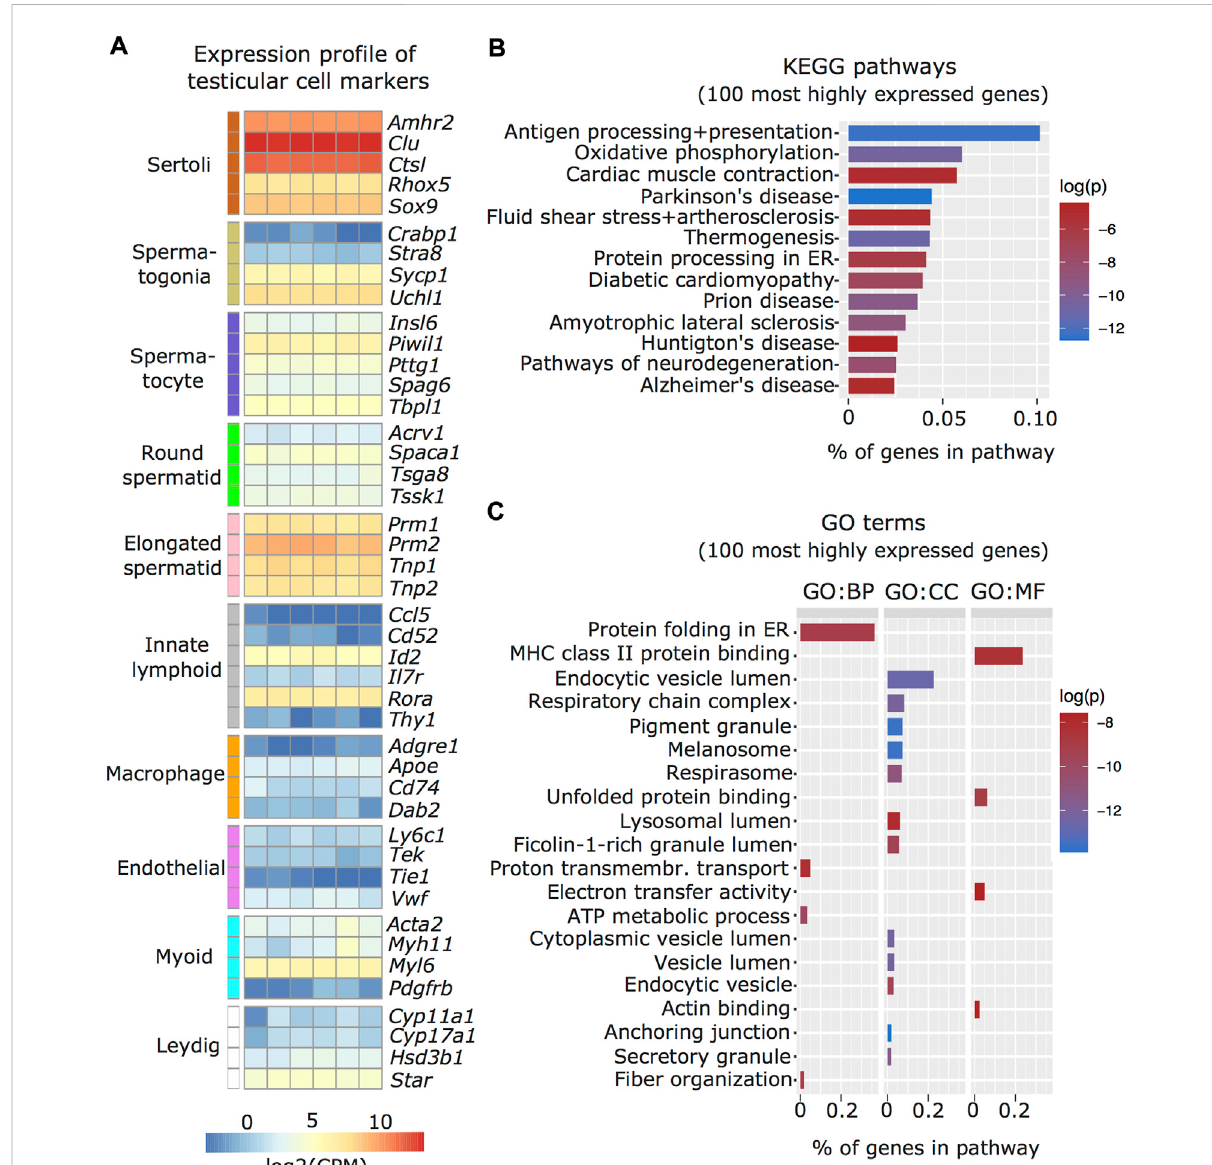
FIGURE 2 Characterization of enriched Sertoli cells by RNA sequencing. (A) Heatmap of testicular cell markers in enriched Sertoli cells, ordered by cell type-speci fi cityincludingSertolicells,spermatogeniccells(spermatogonia,spermatocyte,roundandelongatedspermatid),immunecells(lymphoid and macrophage), endothelial cells, smooth muscle cells (peritubular myoid) and endocrine cells (Leydig). Color scale indicates normalized log2 gene counts per million (CPM). Enriched (B) KEGG and (C) GO pathways for 100 most highly expressed genes in collected Sertoli cells including immunological (e.g. KEGG: Antigen processing and presentation; GO MF: MHC class II protein binding), metabolic (e.g. KEGG: Oxidative phosphorylation, GO CC: respiratory chain complex), cell-cell junction (KEGG: Cardiac muscle contraction, GO, CC: anchoring junction), phagocytosis (GO, CC: endocytic vesicle lumen, lysosomal lumen), and secretion (KEGG: protein processing in ER, GO, CC: secretory granule) pathways.Ratioofgenesperpathwayisgivenonthex-axisandlogofp-value(log( p ))isindicatedonacolorscale.BP:biologicalprocess,CC:cellular component, MF: molecular